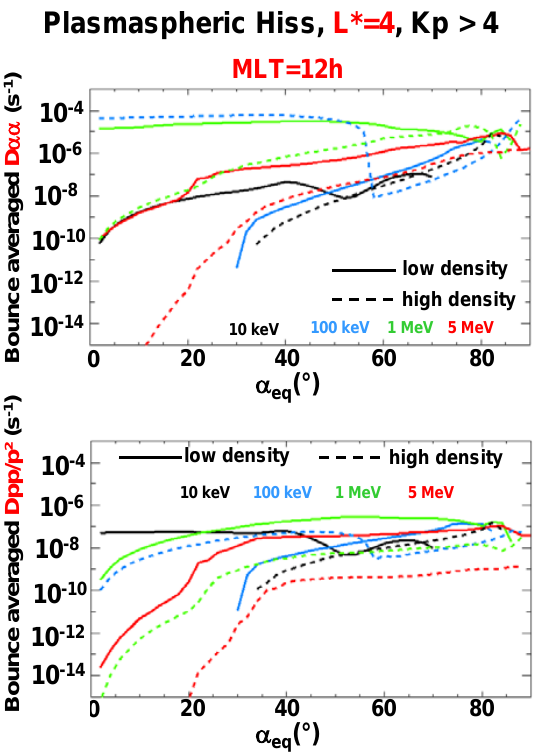
Figure 5. Bounce-averaged pitch angle (top) and energy (bottom) Fig. 5 Bounce-averaged pitch angle (top) and energy (bottom) diffusion rates (s -1 ) for 695 diffusion rates (s − 1 ) for plasmaspherc hiss using WAPI code for 4 energies, 0.01MeV (black), 0.1MeV (blue), 1MeV (green) for and plasmaspherc hiss using WAPI code for 4 energies, 0.01 MeV (black), 0.1 MeV (blue), 1 696 5MeV (red) L ∗ = 2.5, for MLT = 0h, for active magnetic activity (Kp > 4) and for two different plasma densities: 5th percentile in MeV (green) for and 5 MeV (red) L*=2.5, for MLT=0h, for active magnetic activity (Kp>4) 697 solid lines and 95th percentile in dashed lines. and for two different plasma densities: 5 th percentile in solid lines and 95 th percentile in 698 dashed lines. 699